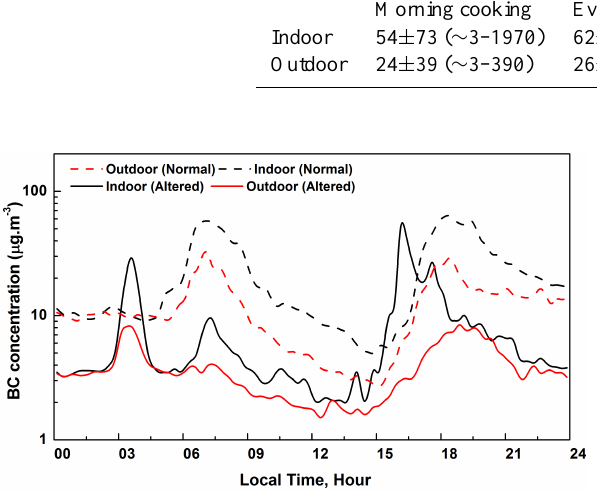
Figure 53 Fig. 5. Comparison of diurnal variation of BC concentration at Surya village (SVI 1) center with highway measurement (locates around 3km to the southeast of SVI